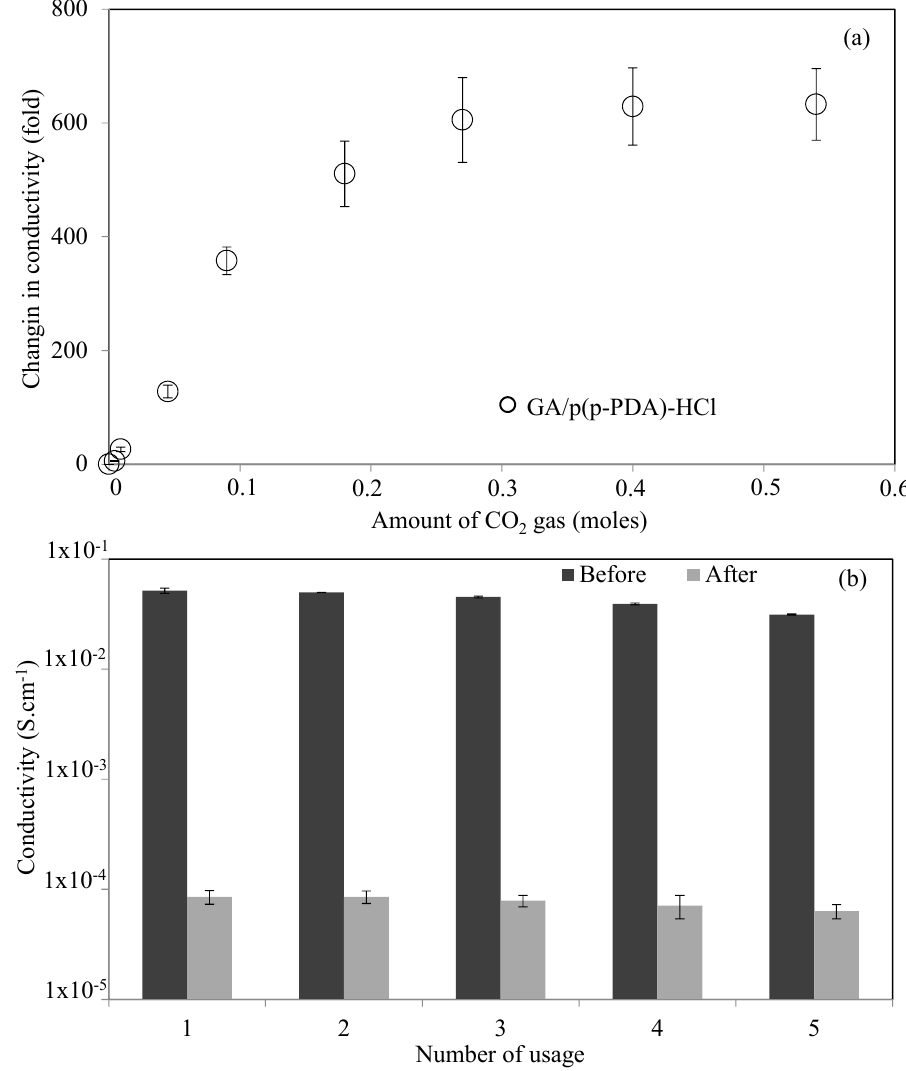
Figure 7. ( a ) The change in the conductivity of GA / p(p-PDA)-HCl composites in the presence of the various amount of CO 2 gas, and ( b ) reusability of GA / p(p-PDA)-HCl composites.